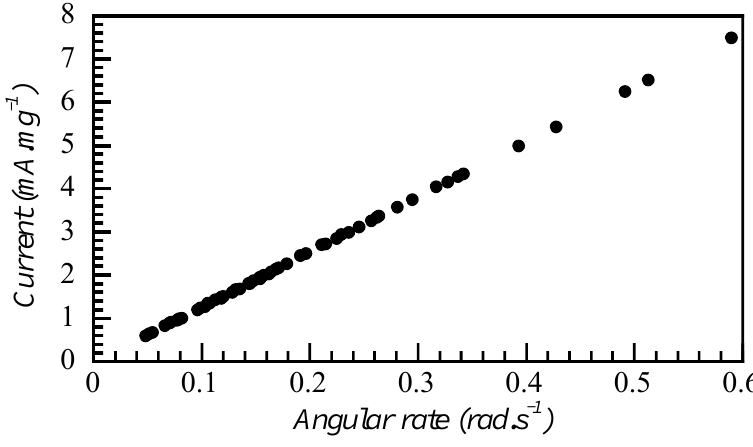
Figure 15. Angular rate measured through a movement of 90 degrees using a triple-layer muscle of different dimensions (including different weights of polypyrrole films: 8.3, 7.8, 7.4, 6, 5.5, 5.1, 5, 4, 3.7, 3.5, 3, 2.3 and 2 mg) in 1M LiClO4 aqueous solution under different currents (10, 15, 20, 25 and 30 mA) (adopted from Reference [167] with kind permission from The Royal Society of